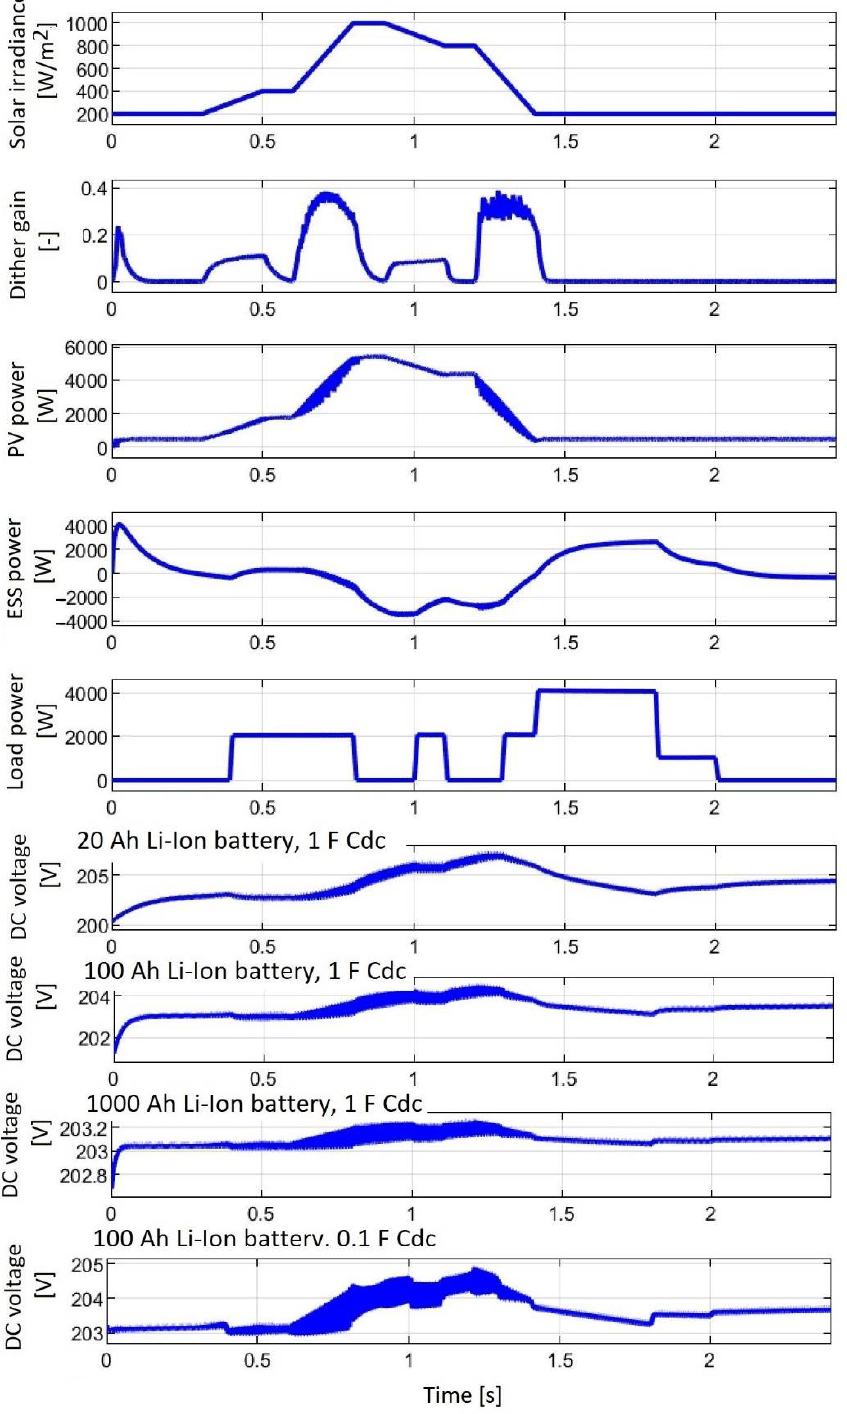
Figure 8. The behavior of the PV/ESS system under variable solar irradiance profile with slow slopes.